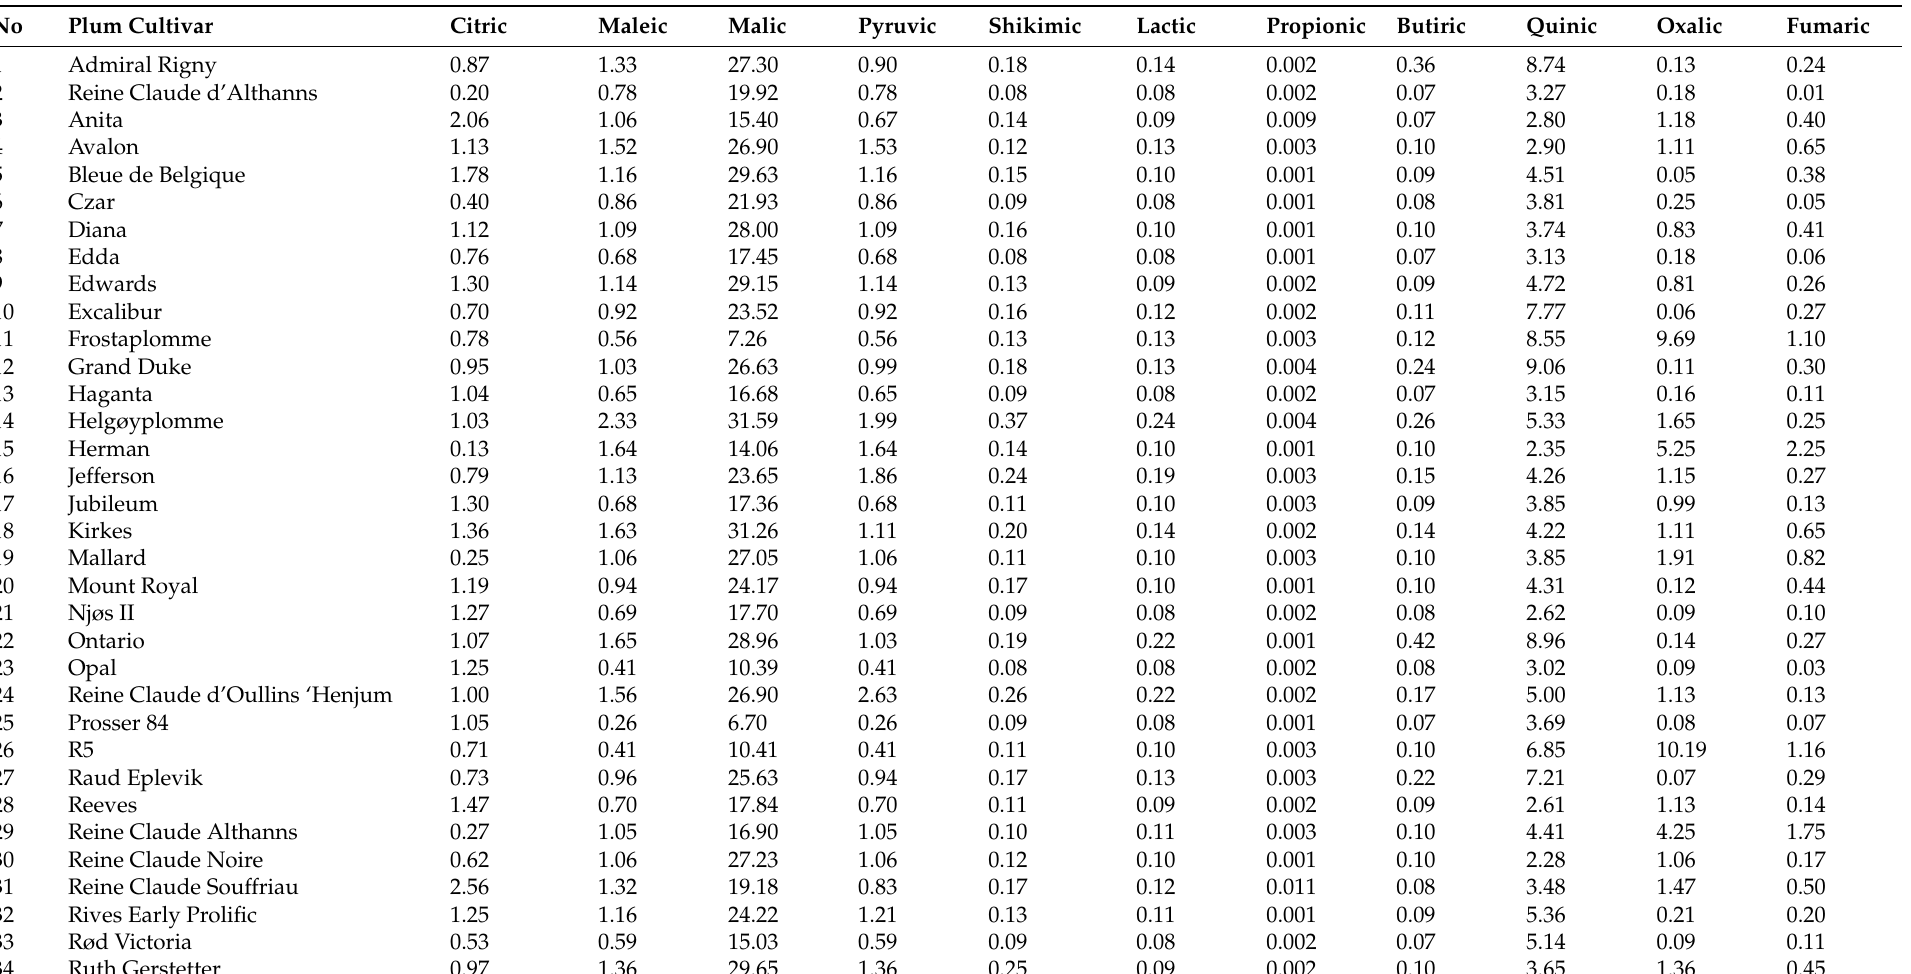
Table A3. Content of organic acids (g/kg dw) in 68 Norwegian plum cultivars from Njøs (42 samples) and NIBIO Ullensvang (8 samples) collected in 2019 and 2021 and from NMBU (18 samples) collected in 2019 and